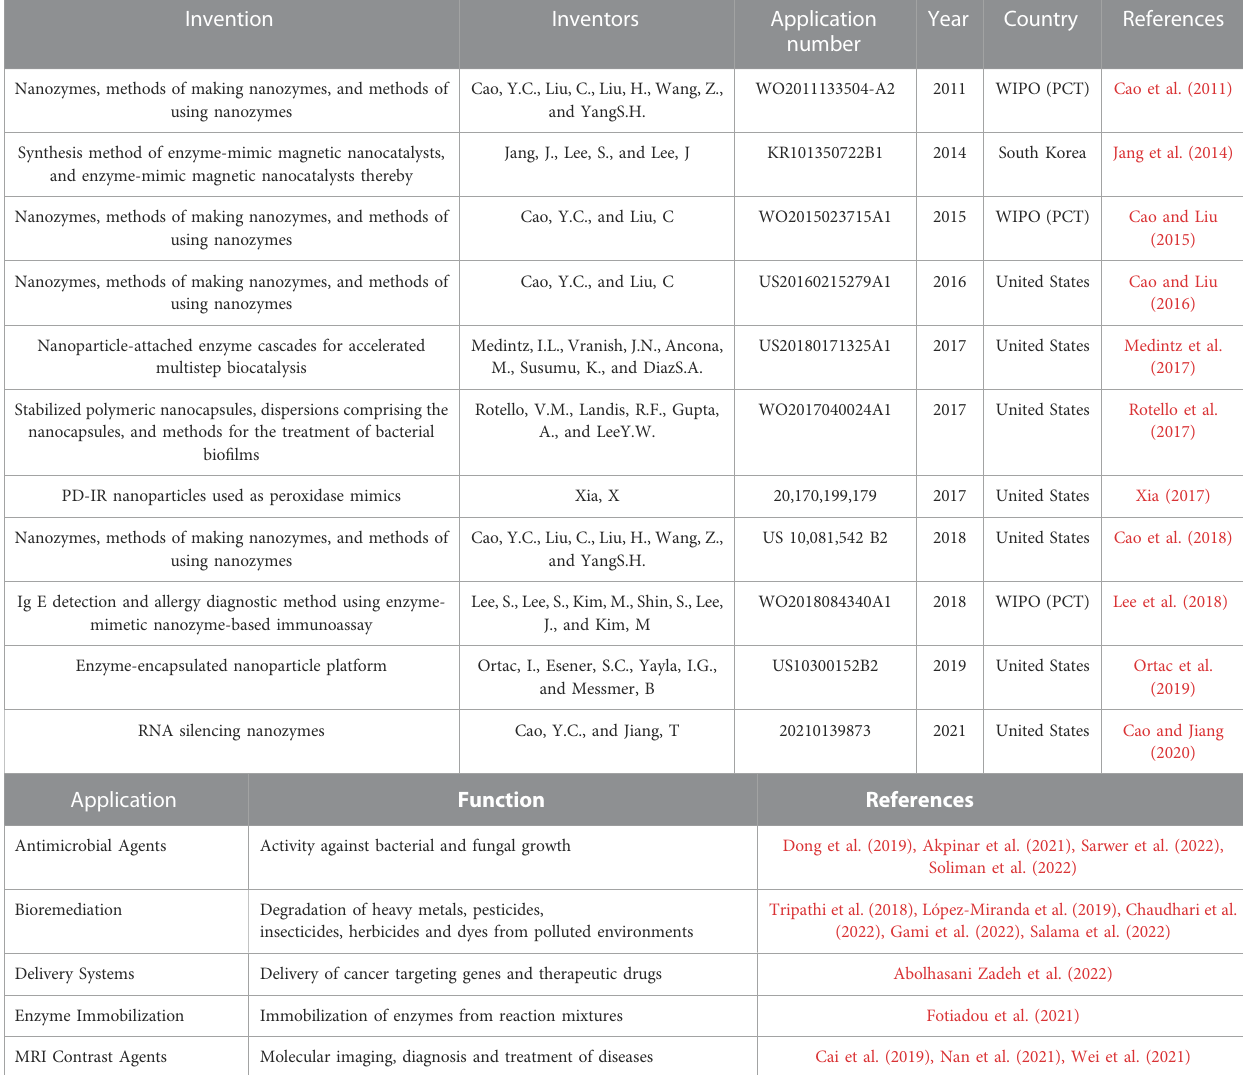
TABLE 1 List of Nanozyme Patent Applications and Summary of Recent Nanoparticle